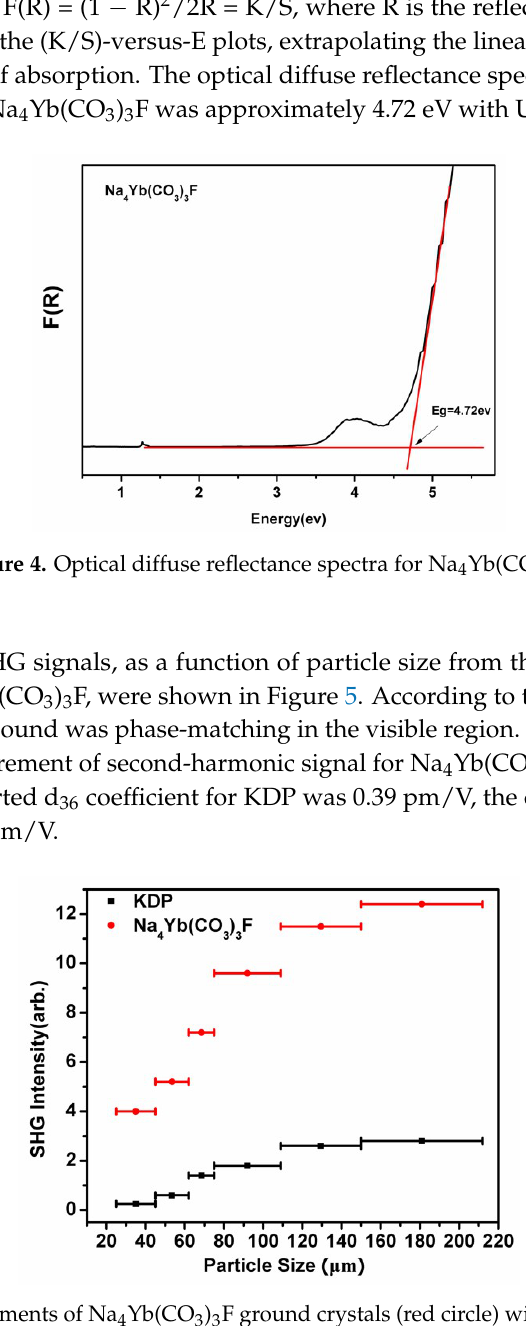
Figure 5. SHG measurements of Na 4 Yb(CO 3 ) 3 F ground crystals (red circle) with KDP (black square) as a reference.